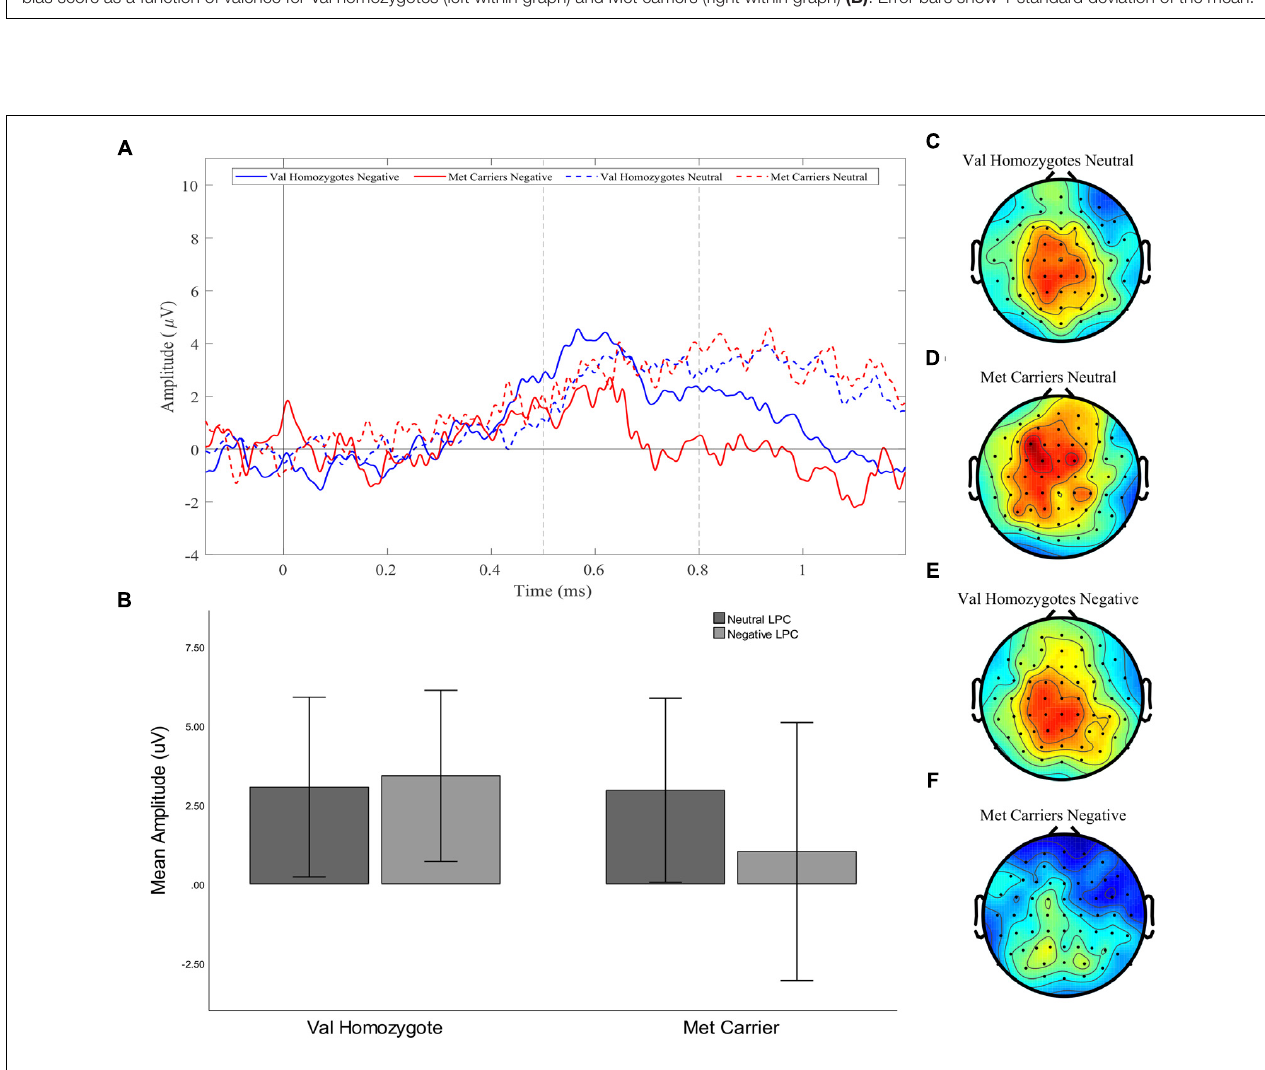
FIGURE 2 | Experiment 1: Old-New difference waves for the Val homozygotes (blue) and Met carriers (red) in negative (solid lines) and neutral (dashed lines) conditions (A) . Mean ( ± 1SD) LPC amplitude of Val homozygotes (left within graph) and Met carriers (right within graph) for the neutral (light gray) and negative (dark gray) conditions (B) . Topographic distribution of LPC effect between 500–800 ms in Val homozygotes neutral condition (C) , Met carriers neutral condition (D) , Val homozygotes negative condition (E) , and Met carriers negative condition (F)